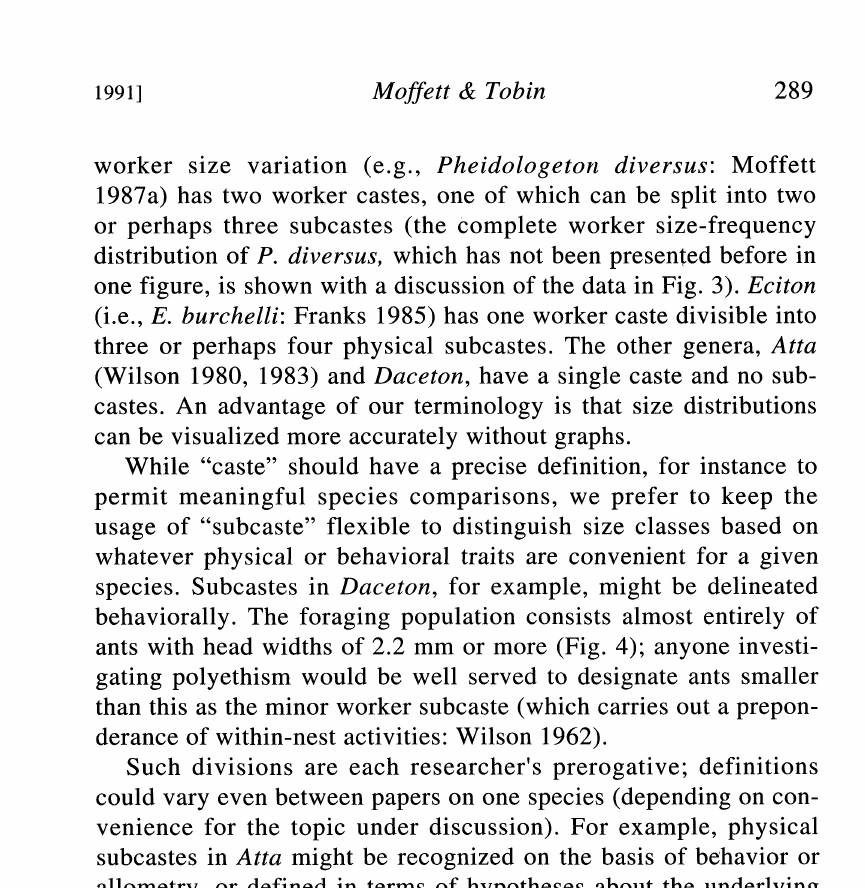
Fig. 3 (opposite). Worker size-frequency distributions in a Pheidologeton diver- sus colony from Singapore (below and left) and a P. pygmaeus colony from Sarawak (top right). The wide size range of P. diversus nonminor workers probably arose from a narrowly defined major caste in a P. pygmaeus-like ancestor. Measurements for the P. diversus colony were made on a sample of 1,080 minor workers and separately on a sample of 278 nonminors; the minor workers made up at least 99% of all workers in the colony, so if the minor worker peak was correctly proportioned on this page relative to the nonminors, the peak would be five meters tall! The largest worker in the whole colony was not in this sample (5.63 mm); the absolute gap of 0.46 mm between the largest minor and smallest nonminor was con- firmed further for this colony by measurements of an additional 830 minors in the course of behavioral experiments prior to colony excavation. Measurements for P. pygmaeus were made for 50 minors and 50 nonminors (majors)rathe latter made up less than 0.5% of the worker labor